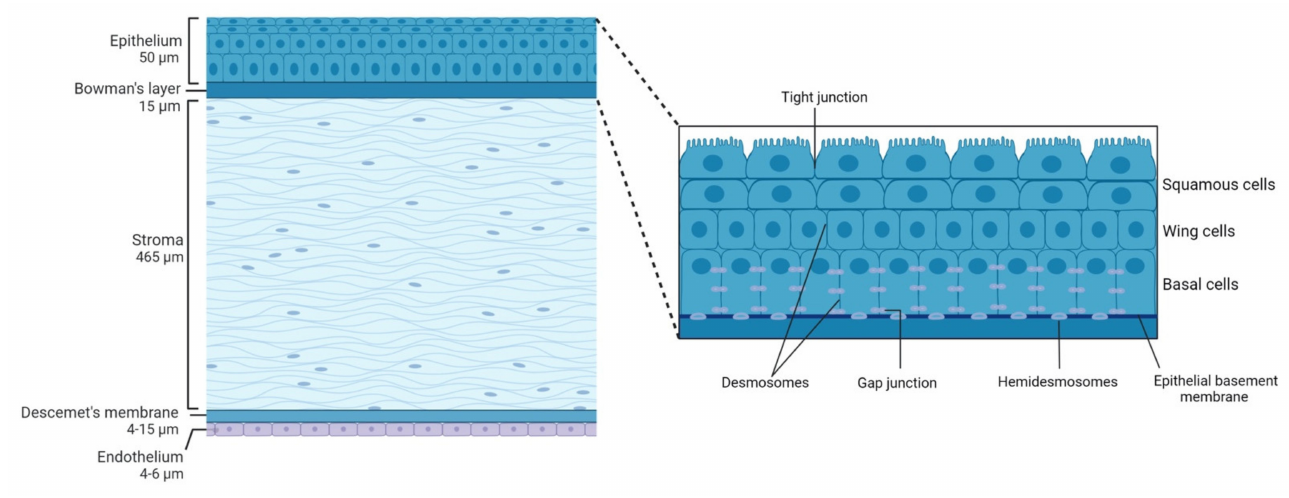
Figure 1. Schematic representation of the corneal structure, showing its five main layers and their thickness. Inset: diagram of the corneal epithelium, showing its different cell layers and details on the different types of cell-cell junctions contributing to corneal epithelium